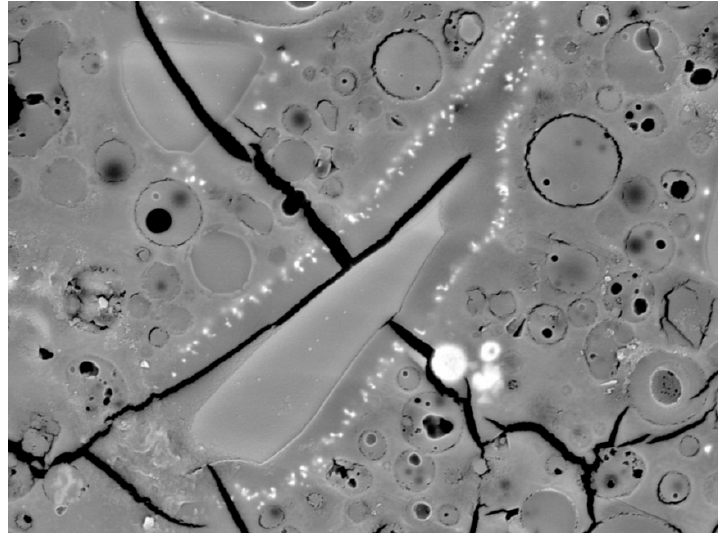
Figure 6. SEM image of Pb coating on the BFS grain, magnitude 4000×. Table 5. EDS analysis of the Pb coating (atom %).